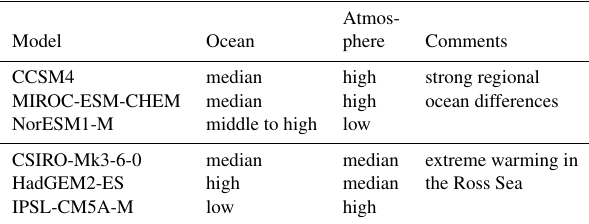
Table 2. Selected AOGCMs for Antarctica and their qualitative pro- jected